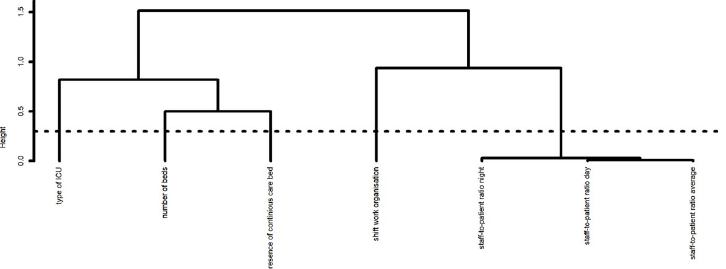
Fig 2. Dendrogram of the hierarchy of the 7 variables at ICU-level. Dotted line depicts the best cut-off of clusters according to the bootstrap approach.